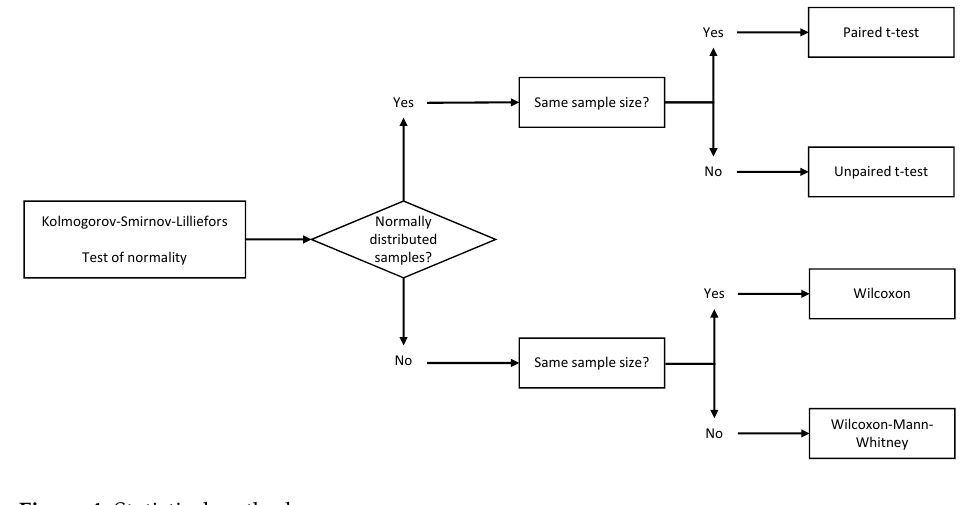
Figure 4. Statistical